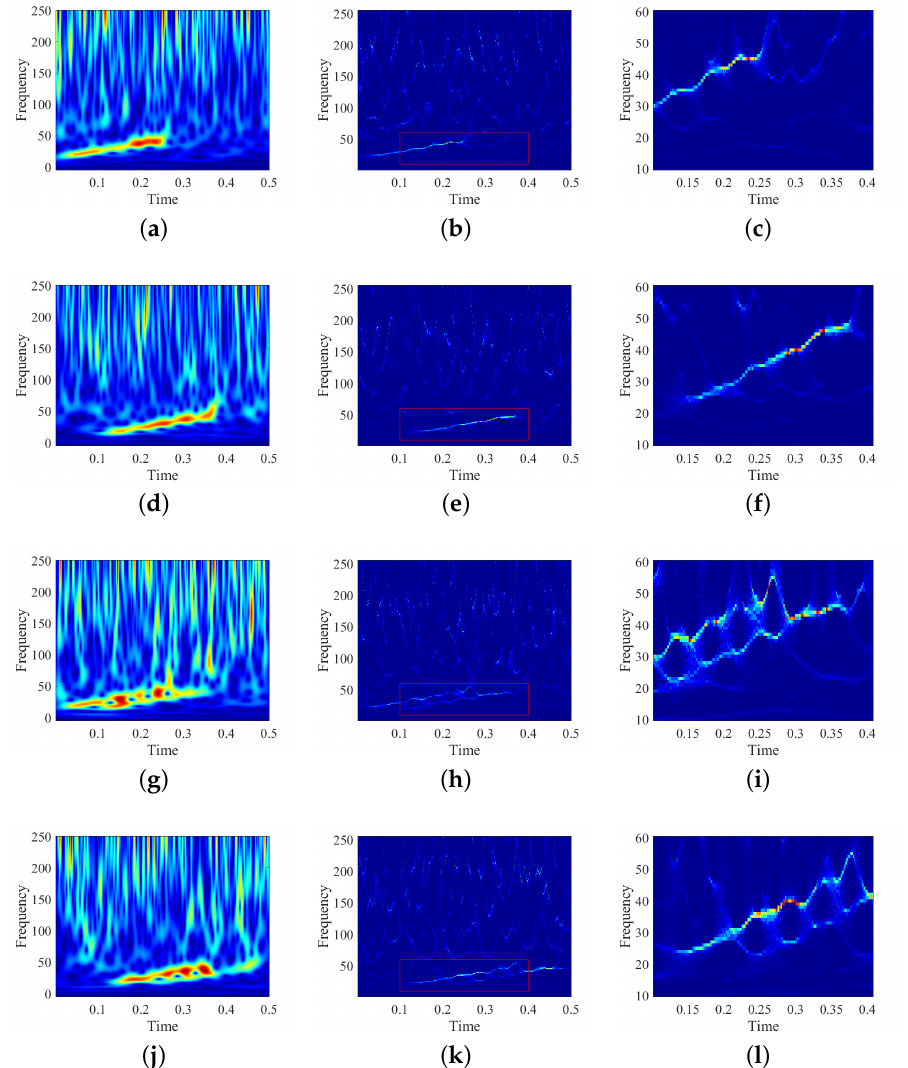
Figure 8. STFT and SST of the signal with multipath effect in different E m and τ . ( a – c ) are STFT, SST, and enlarged part of SST with E m = 0.2 and τ = 16. ( d – f ) are STFT, SST, and enlarged part of SST with E m = 0.2 and τ = 128. ( g – i ) are STFT, SST, and enlarged part of SST with E m = 0.8 and τ = 16. ( j – l ) are STFT, SST, and enlarged part of SST with E m = 0.8 and τ =